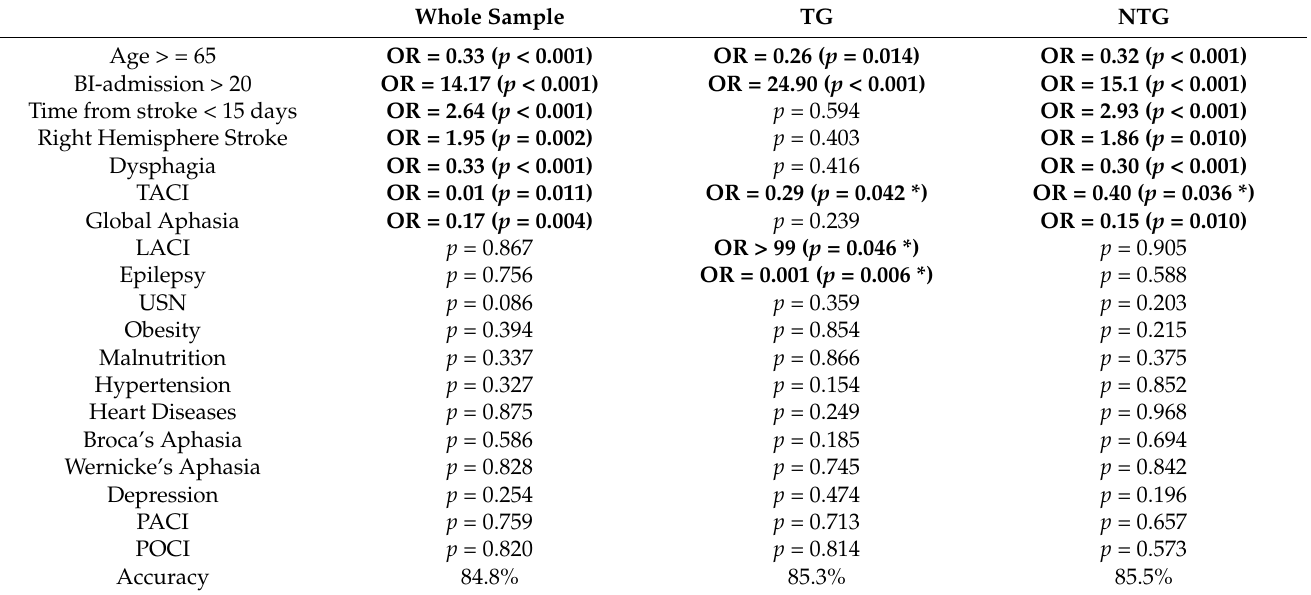
Table 3. Results of Binary Logistic Regression reporting the odd ratios (OR) and related p